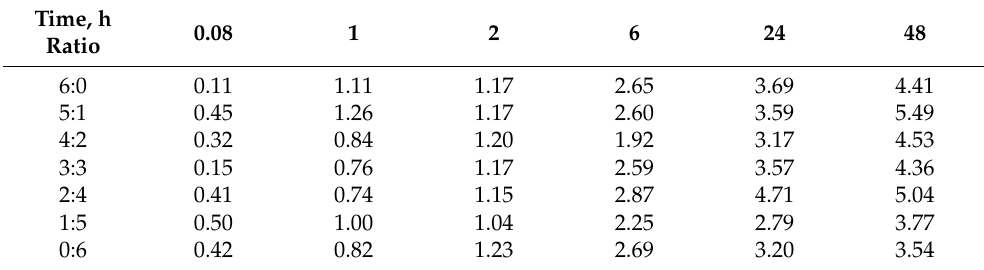
Table 1. The polymer chain binding degree of the europium ions at different ratios of the ion exchangers ( θ , %). Table 2. The polymer chain binding degree of the scandium ions at different ratios of the ion ex- changers ( θ , %).